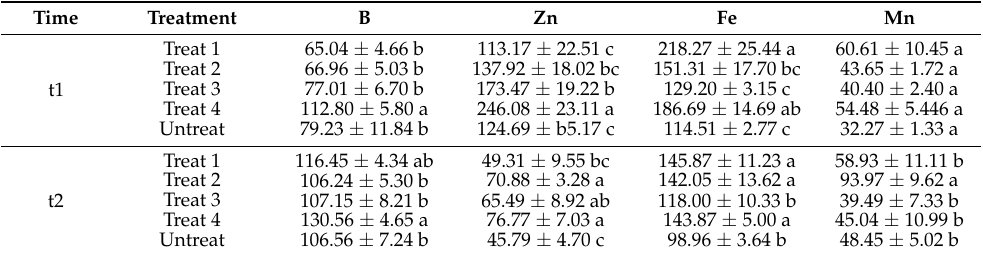
Table 3. Micro- elements composition at the two sampling date. In column and for each period, different letters indicate significant differences ( p <